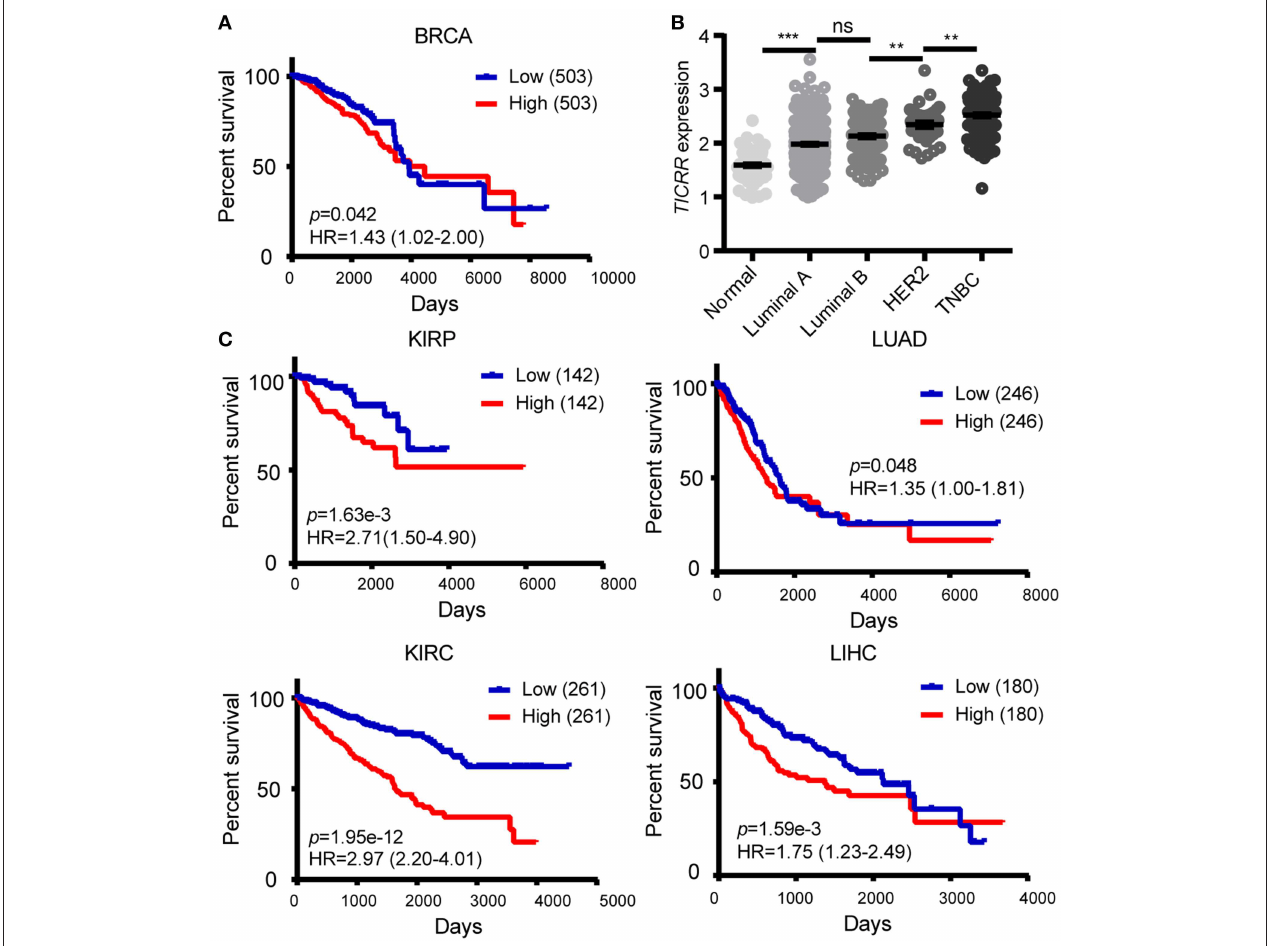
FIGURE 9 | Association of TICRR expression with clinical outcomes. (A) Kaplan-Meier survival analysis was conducted between TICRR expression and overall survival of patients with BRCA using the web-tool OncoLnc. (B) Patients with different subtypes of breast cancer showed different expression levels of TICRR [log10(1 + FPKM)]. Luminal A, ER/PR-positive and HER2-negative; luminal B, ER/PR-positive and HER2-positve; HER2, ER/PR-negative and HER2-positve; TNBC, ER/PR-negative and HER2-negative. ** p < 0.01, *** p < 1.00 × 10 − 3 , one-way ANOVA test. Results were displayed as means ± SEM. (C) Kaplan-Meier